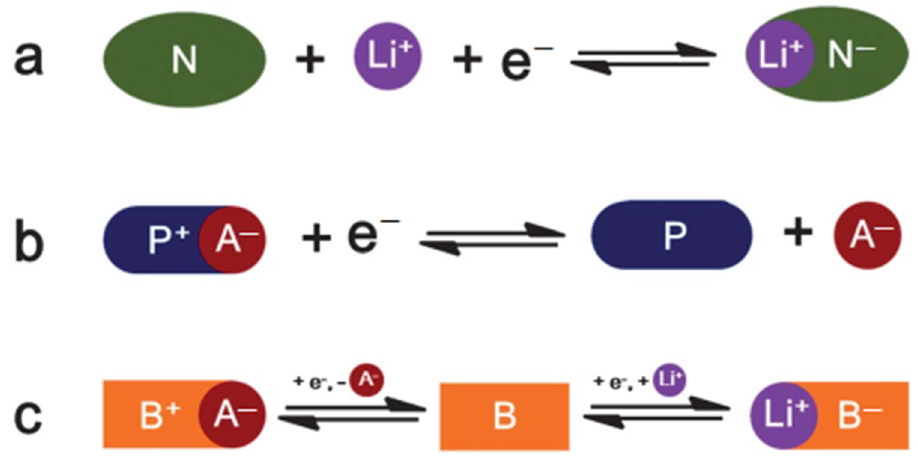
Figure 2. The reversible redox reaction of three types of redox-active organic compounds: ( a ) N-type; ( b ) P-type; ( c ) bipolar. The anion of the electrolyte is denoted as A − . Used with permission from the Royal Society of Chemistry, from Ref. [39]; permission conveyed through Copyright Clearance Center, Inc.